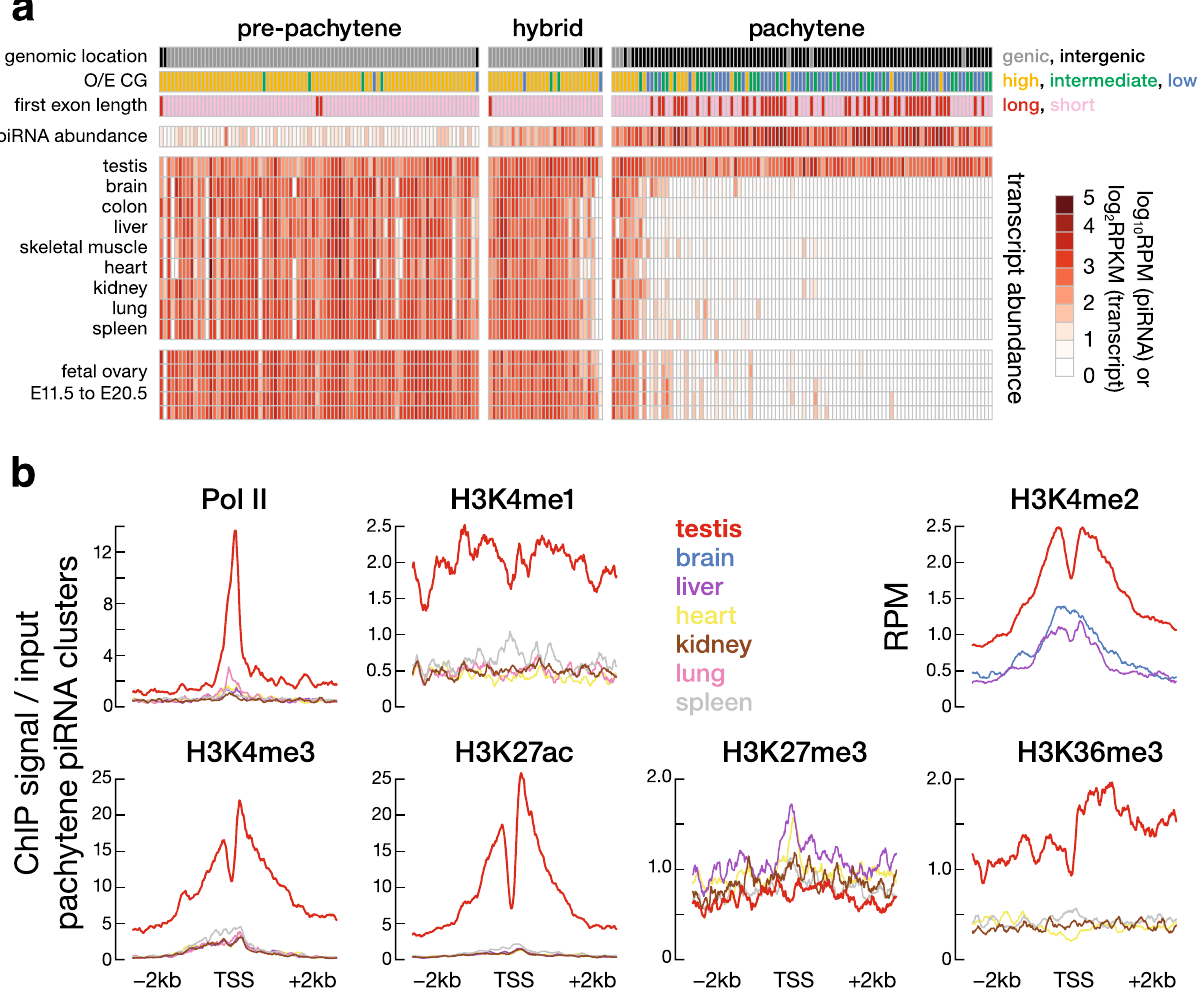
Fig. 1 Mouse pachytene piRNA clusters show testis-speci fi c expression and epigenetic signals. a Each column represents a piRNA gene, grouped by type (pachytene, hybrid, and pre-pachytene) and sorted by tissue-speci fi city score ( “ Methods ” ) within each group. Each piRNA gene is further annotated by its function as an mRNA (black/grey), low, intermediate, or high-CG level at the promoter (low-CG, intermediate-CG, or high-CG; in blue, green, and yellow), length of fi rst exon or length of intronless gene ( ≥ 10 or <10 kb; in red and pink), piRNA abundance (RPM) in adult testis, and transcript expression level (RPKM) in the testis, eight somatic tissues, and fetal ovary. piRNA abundance and transcript expression levels are log 2 and log 10 transformed, respectively, with a pseudo-count of 1 and share the same color scale. b Each panel indicates the levels of RNA pol II binding or a histone mark; tissues are color coded. Pachytene piRNA clusters exhibit high levels of activating histone marks (H3K4me3, H3K4me2, H3K4me1, H3K27ac, and H3K36me3), low levels of the repressive histone mark H3K27me3, and high levels of RNA pol II binding speci fi cally in adult testis. ChIP-seq signals are shown in a ±2 kb window around the TSS in 10 bp bins. H3K4me2 ChIP-seq data were publicly available only for testis, liver, and brain. We performed two-sided Wilcoxon signed-rank tests to compare epigenetic signals at pachytene piRNA clusters in the testis versus somatic tissues. Pol II, p < 2.2 × 10 − 16 ;